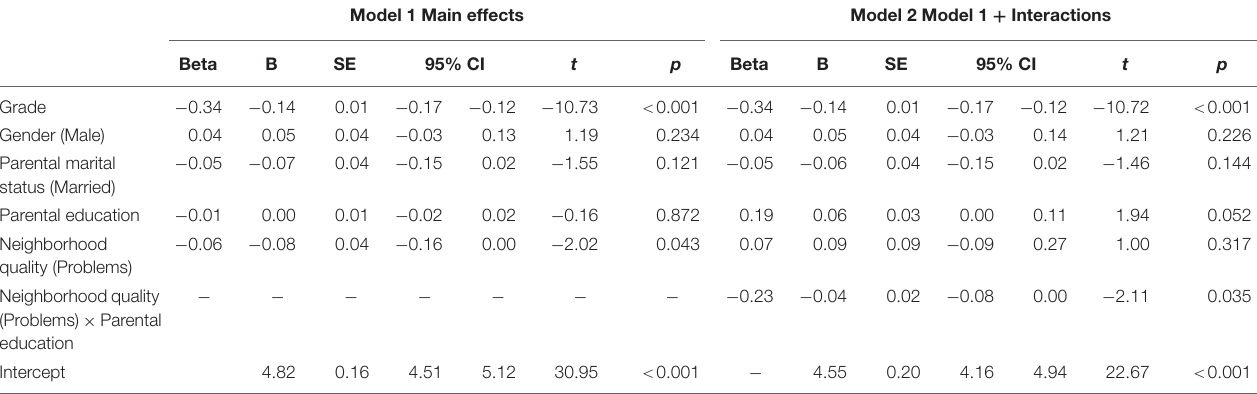
TABLE 3 | Summary of linear regressions ( n =